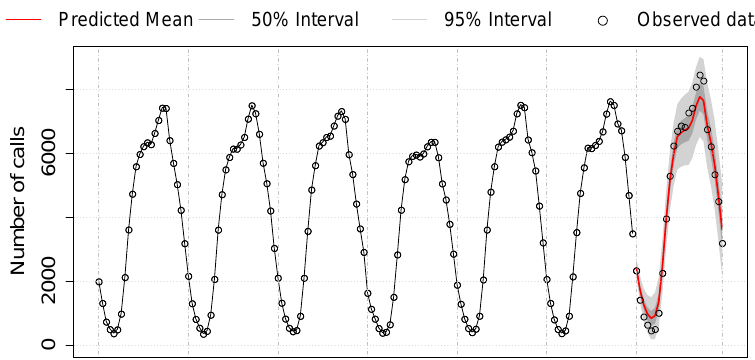
Figure 21. Forecast of one-day traffic from a seasonal ARIMA model fitted on concurrent voice-calls data over six